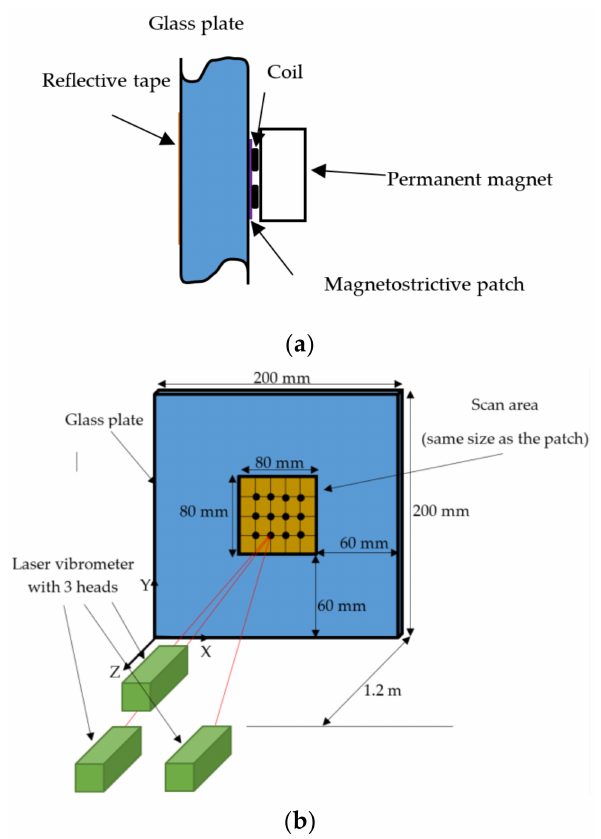
Figure 2. ( a ) A cross-section of the measurement setup, showing the relative location of the coil, permanent magnet and magnetostrictive patch making up the MPT, plus the reflective tape on the far surface of the glass plate; ( b ) Schematic diagram of the three vibrometer heads (green) incident upon the reflective tape (orange) which was attached to the far side of the glass plate